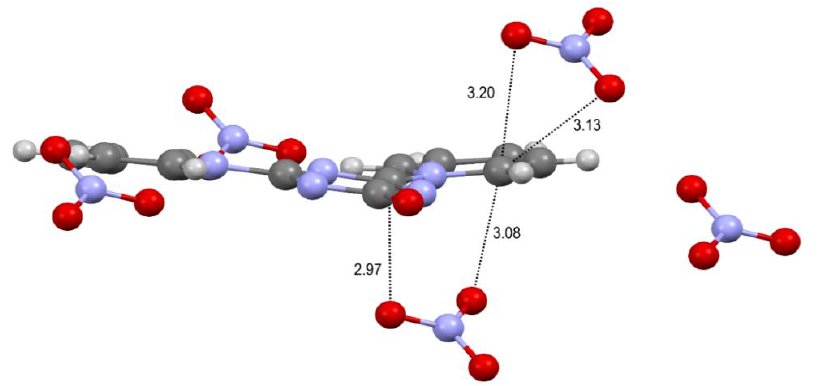
Figure 7. A cation surrounded by nitrate ions in the 4b structure, with three nitrates in the same layer and two from the adjacent layers.